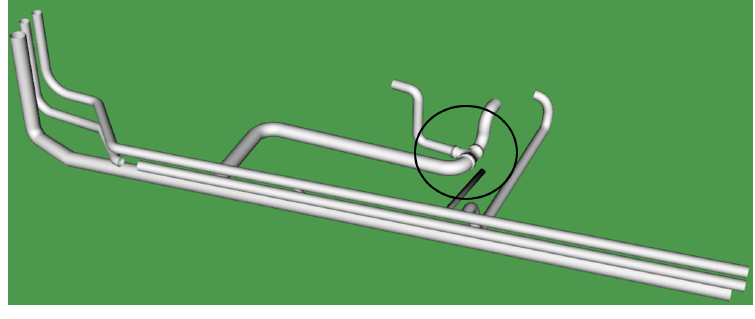
Figure 9. Predefined CAD Model 1.